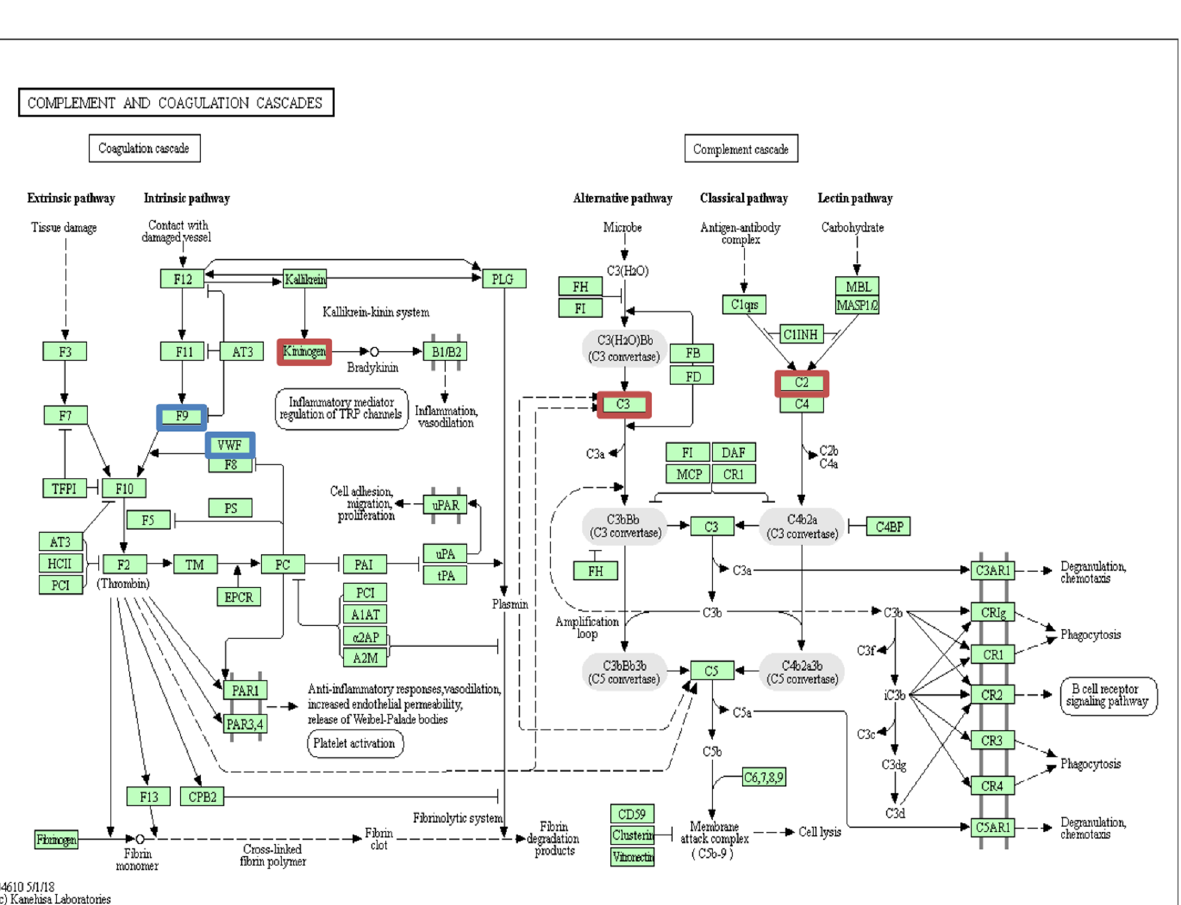
Figure 3. An illustration of the complement and coagulation cascades (homosapiens) from Kyoto Encyclopedia of Genes and Genome (KEGG) (https ://www.genom e.jp/kegg-bin/show_pathw ay?hsa04 610). A total of 5 (out of 78) proteins were significantly enriched. Proteins that showed significantly lower and higher concentrations in preeclampsia are shown in red and blue